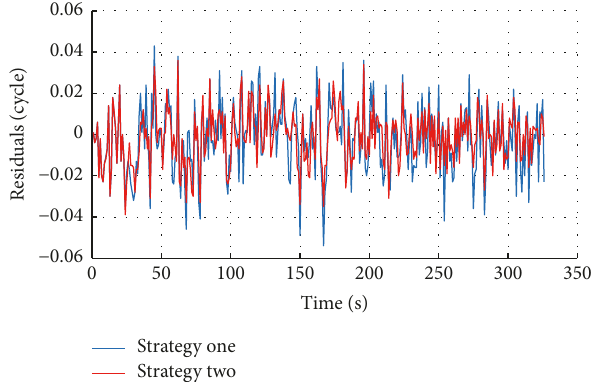
Figure 14: Residuals of satellite PRN 2 using two processing